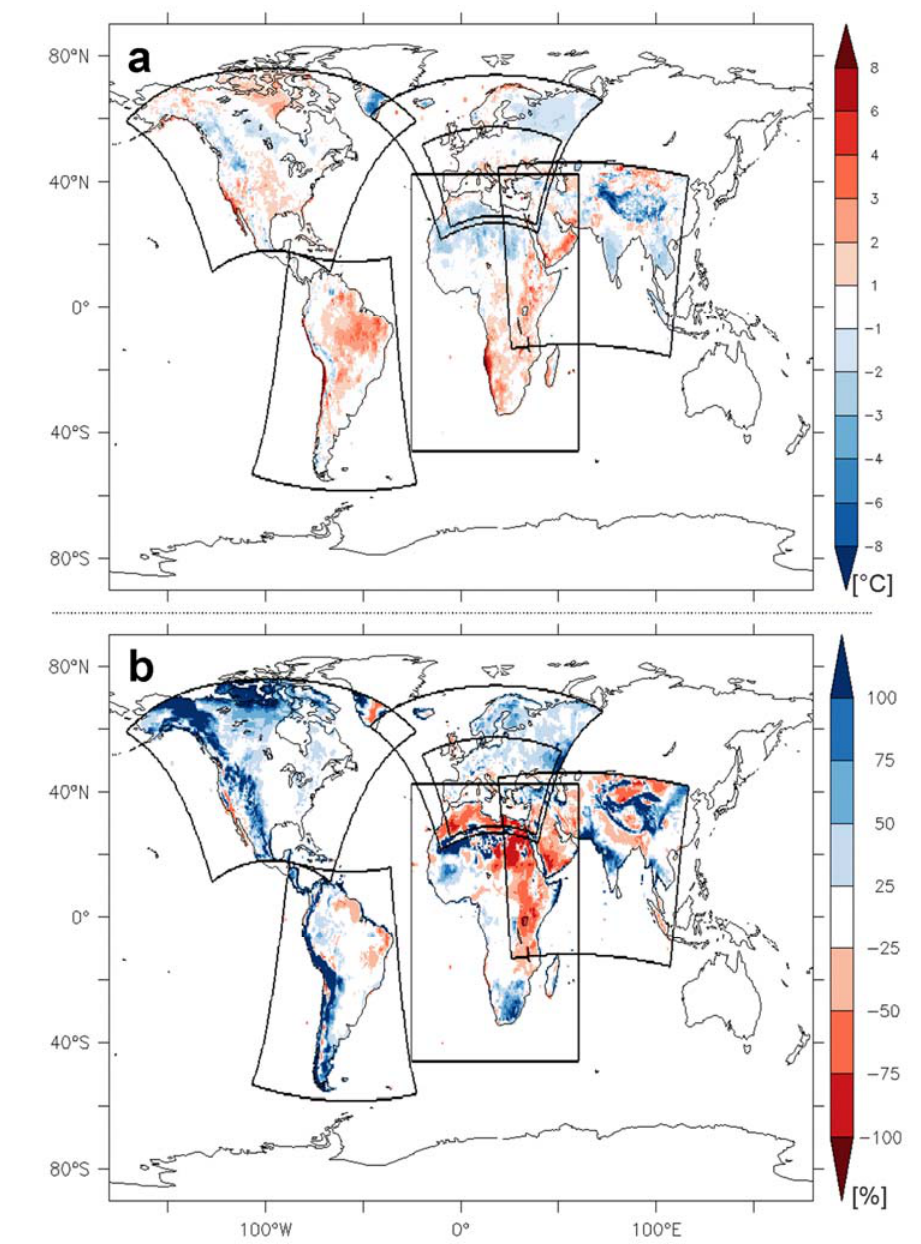
Figure 3. ( a ) Differences of simulated and observed (CRU) annual mean air temperature (2 m height) in [°C]; ( b ) Relative annual mean differences between simulated and observed (CRU) precipitation in [%]. The period considered is 1989 to